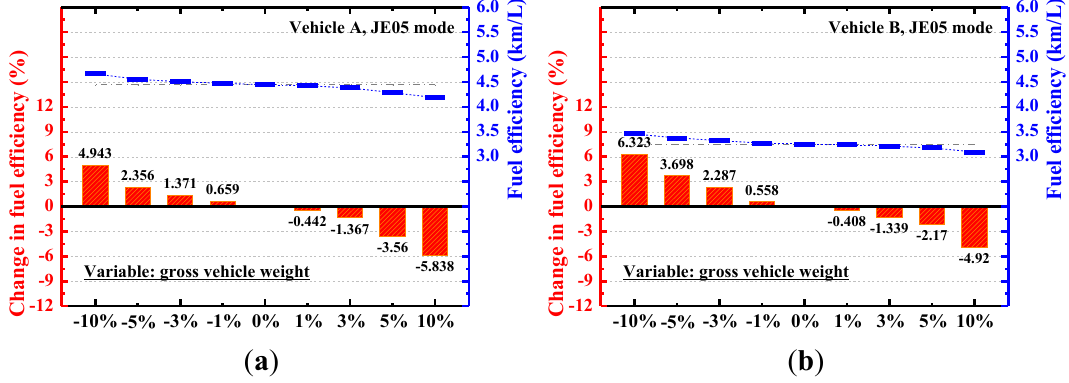
Figure 16. Change of the predicted fuel efficiency results with variation of the gross vehicle